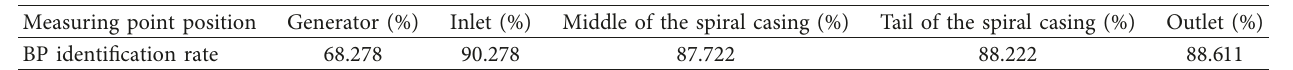
Figure 15: Identification rates of three units based on MRFO-BP neural network. (a) Generator; (b) middle of the spiral casing; (c) tail of the spiral casing; (d) outlet. Table 4: Identification rates of three units based on BP neural